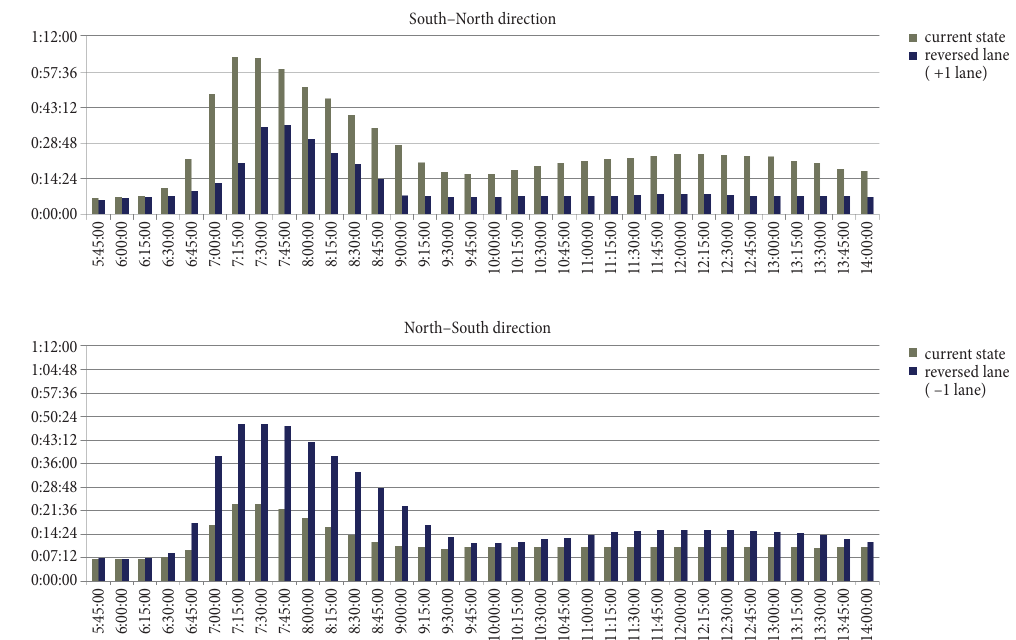
Fig. 6. Results of simulation of arrival times (source: own elaboration)